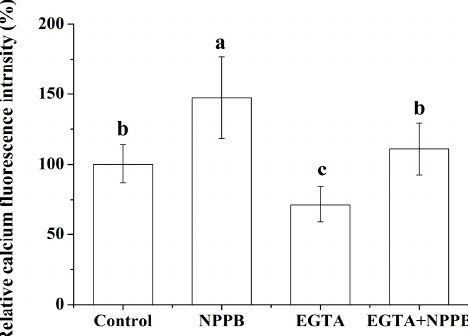
Figure 4. Effect of Ca 2+ chelator (EGTA) on cytosolic Ca 2+ fluorescence intensity in NPPB-treated tea roots. Control, NPPB and EGTA indicate distilled water, 50 µ M NPPB, and 1 mM EGTA for 0.5 h respectively; EGTA + NPPB refers to tea roots were placed in 1 mM EGTA for 0.25 h, then subjected EGTA + NPPB treatment in tea lateral roots. Data indicate mean ˘ SD ( n = 4). Error bars indicate of significance as compared with control at p <